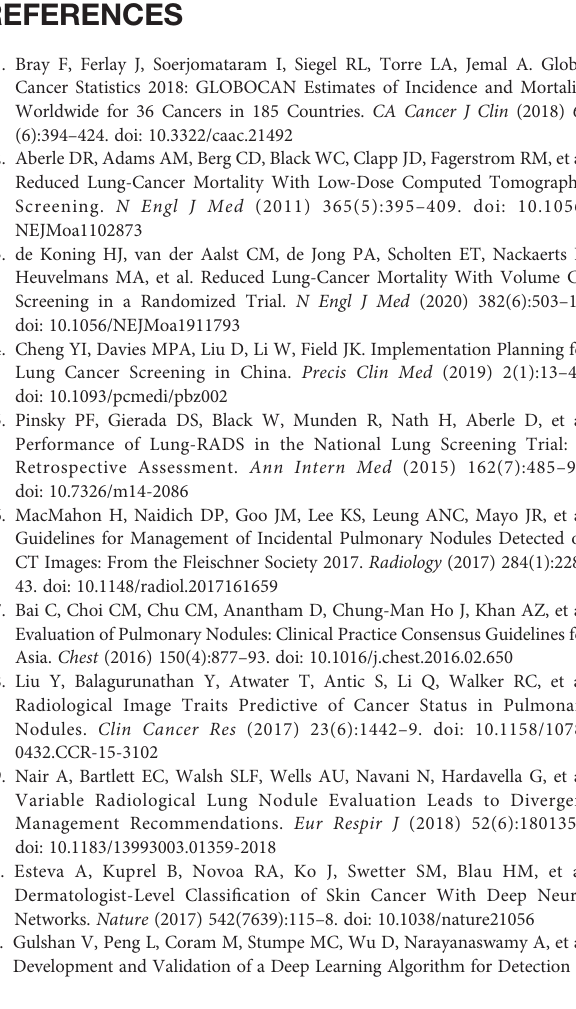
Supplementary Table 1 | CLAIM: Checklist for Arti fi cial Intelligence in Medical